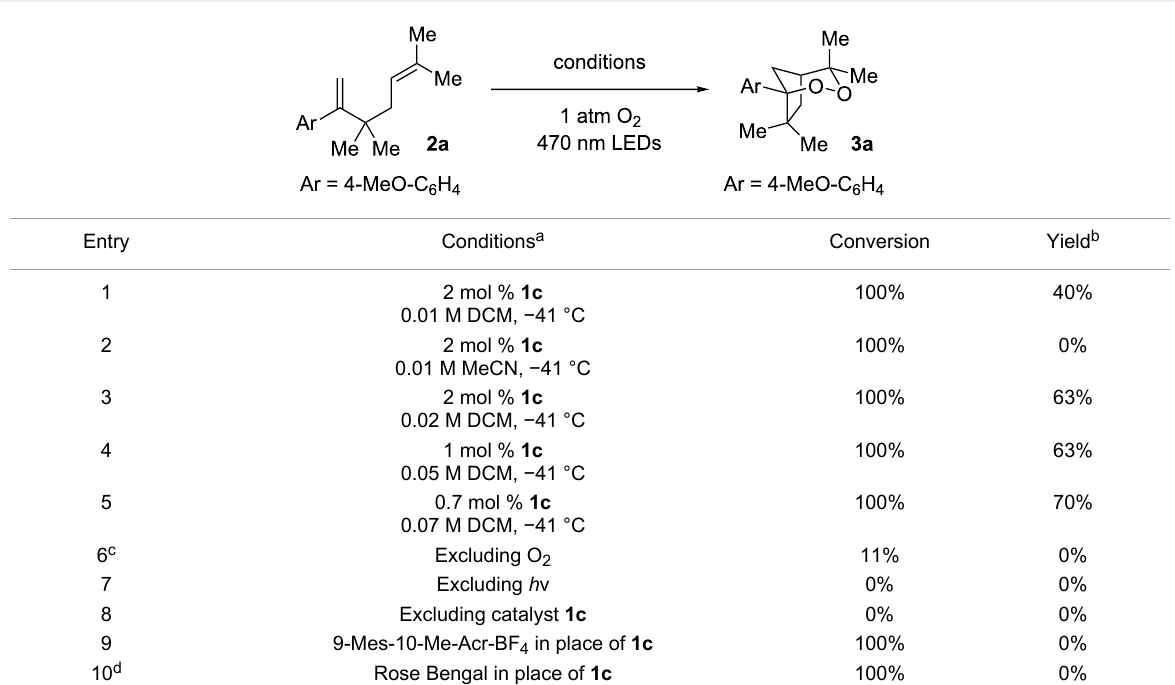
Table 1: Reaction Optimization and Control